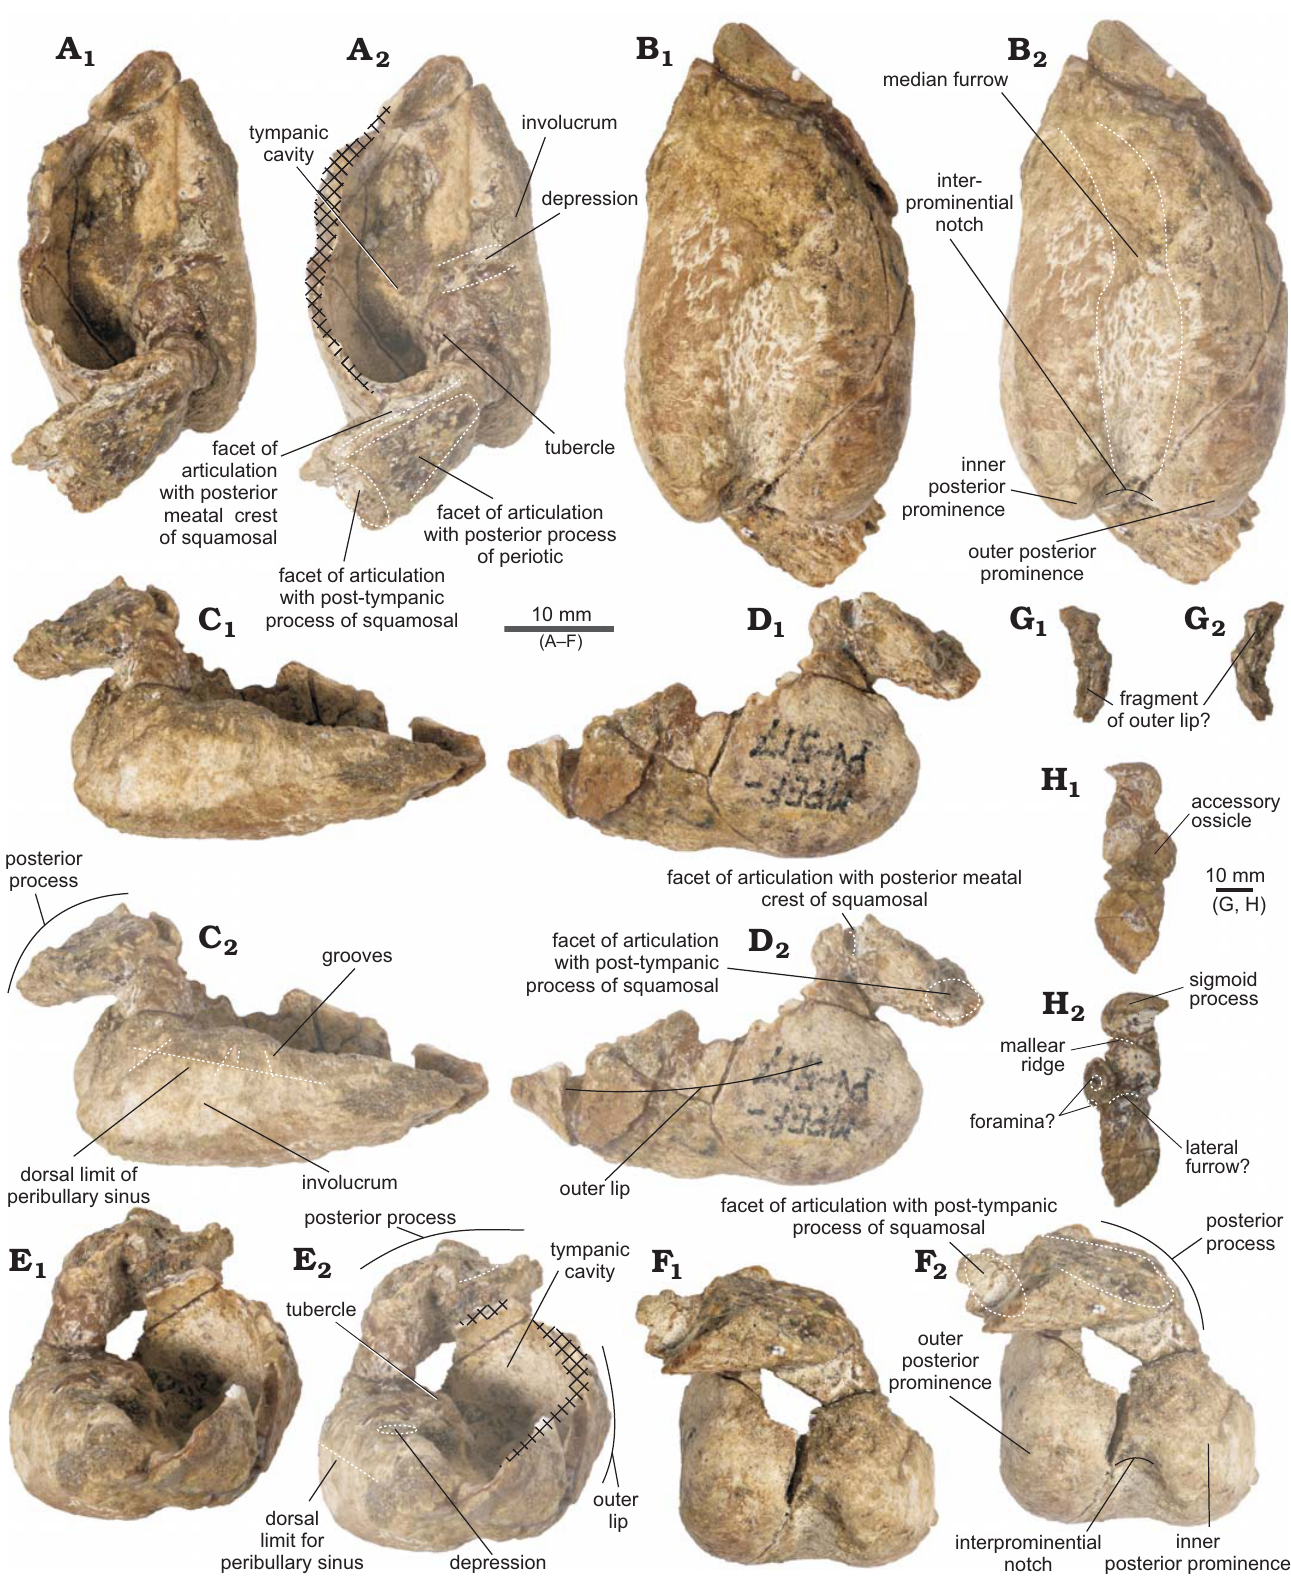
Fig. 6. Left tympanic bulla of the holotype of the platanistoid dolphin Aondelphis talen gen. et sp. nov. (MPEF-PV 517) from the early Miocene Gaiman For mation, Bryn Gwyn, Patagonia, Argentina; in dorsal ( A ), medial ( B ), ventral ( C ), lateral ( D ), anterior ( E ), and posterior ( F ) views. Isolated fragments sigmoid process ( G ) and a portion of outer lip ( H ); in posterior (G 1 , H 1 ) and anterior (G 2 , H 2 ) views. Dashed lines indicate specific structures. Hatched outlines show broken areas of the specimen. Photographs (A 1 –F 1 ), photographs with explanations (A 2 –F 2 , G,